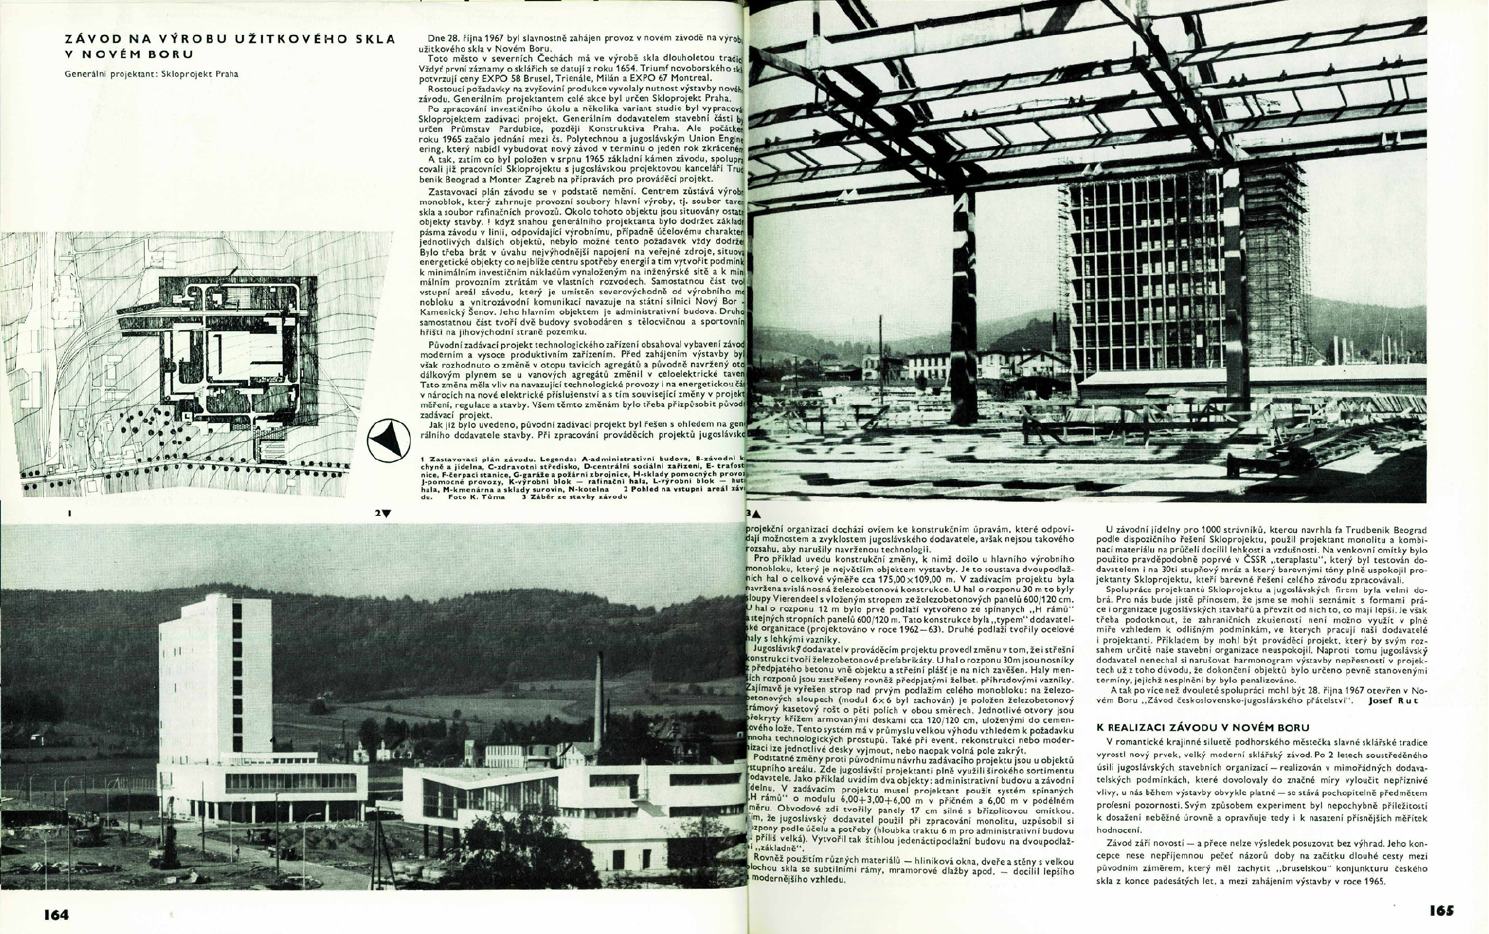
Glass factory, Nový Bor, Czech Republic, n.d. Construction: KMG Trudbenik (Source: Ar- chitektura ČSR , 1968,